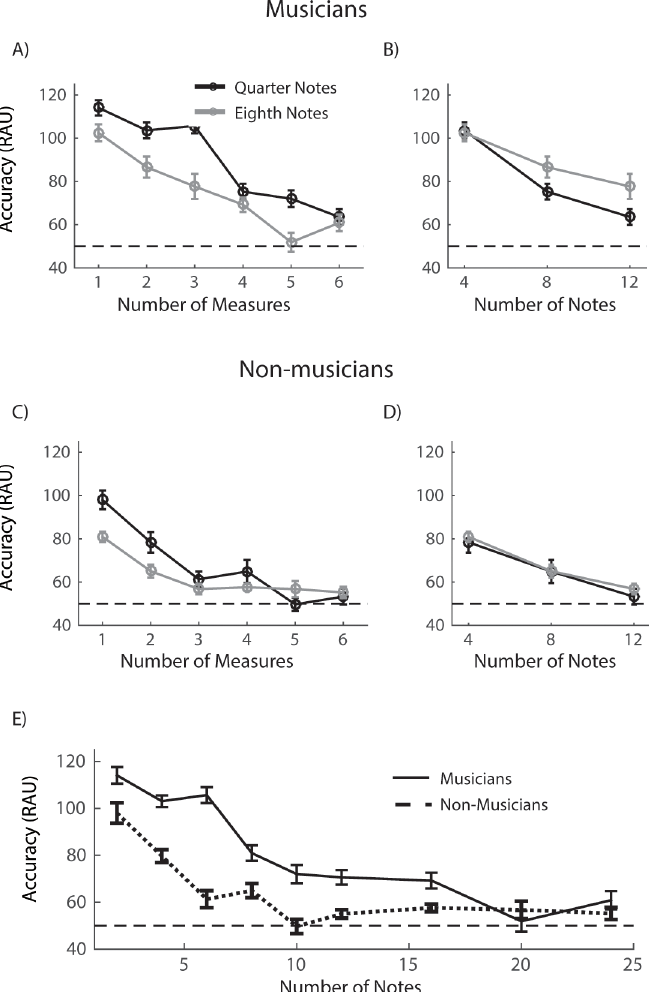
Fig 2. Results of tonal discrimination task in musical tone sequence condition. ( A , C ) Performance of musicians ( A ) and non-musicians ( C ) as a function of the number of measures for quarter note (black curve) and eighth note (grey curve) conditions. The performance is plotted as the d-prime value. ( B , D ) Performance of musicians ( B ) and non-musicians ( D ) as a function of the number of notes for quarter note (black curve) and eighth note (grey curve) conditions. ( E) Combined analyses of the quarter and eighth note conditions. Performance of musicians (solid curve) and non-musicians (dashed curve) as a function of the number of notes in a sequence. Horizontal dashed lines in all plots represent the chance level. Error bars are corrected S.E.M across participants. Stars mark the significant difference comparing to the chance level.